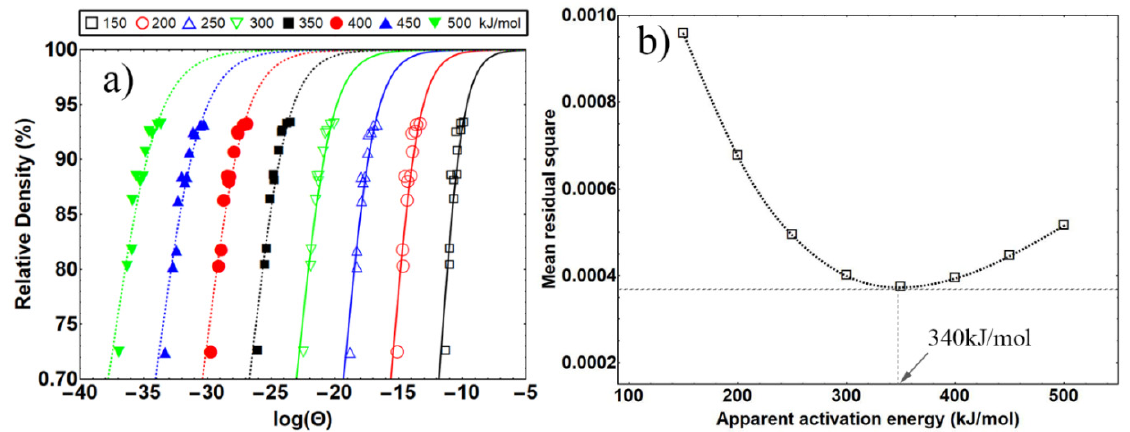
Figure 2. Densification tendency of samples prepared at ( a ) different heat-ramp rate, ( b ) isothermal duration at different temperatures.